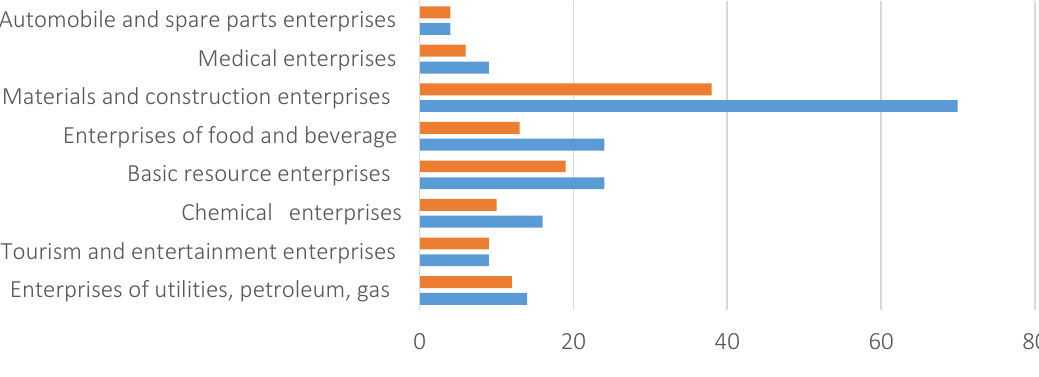
Table 3. The results for the level of environmental information reporting by industries